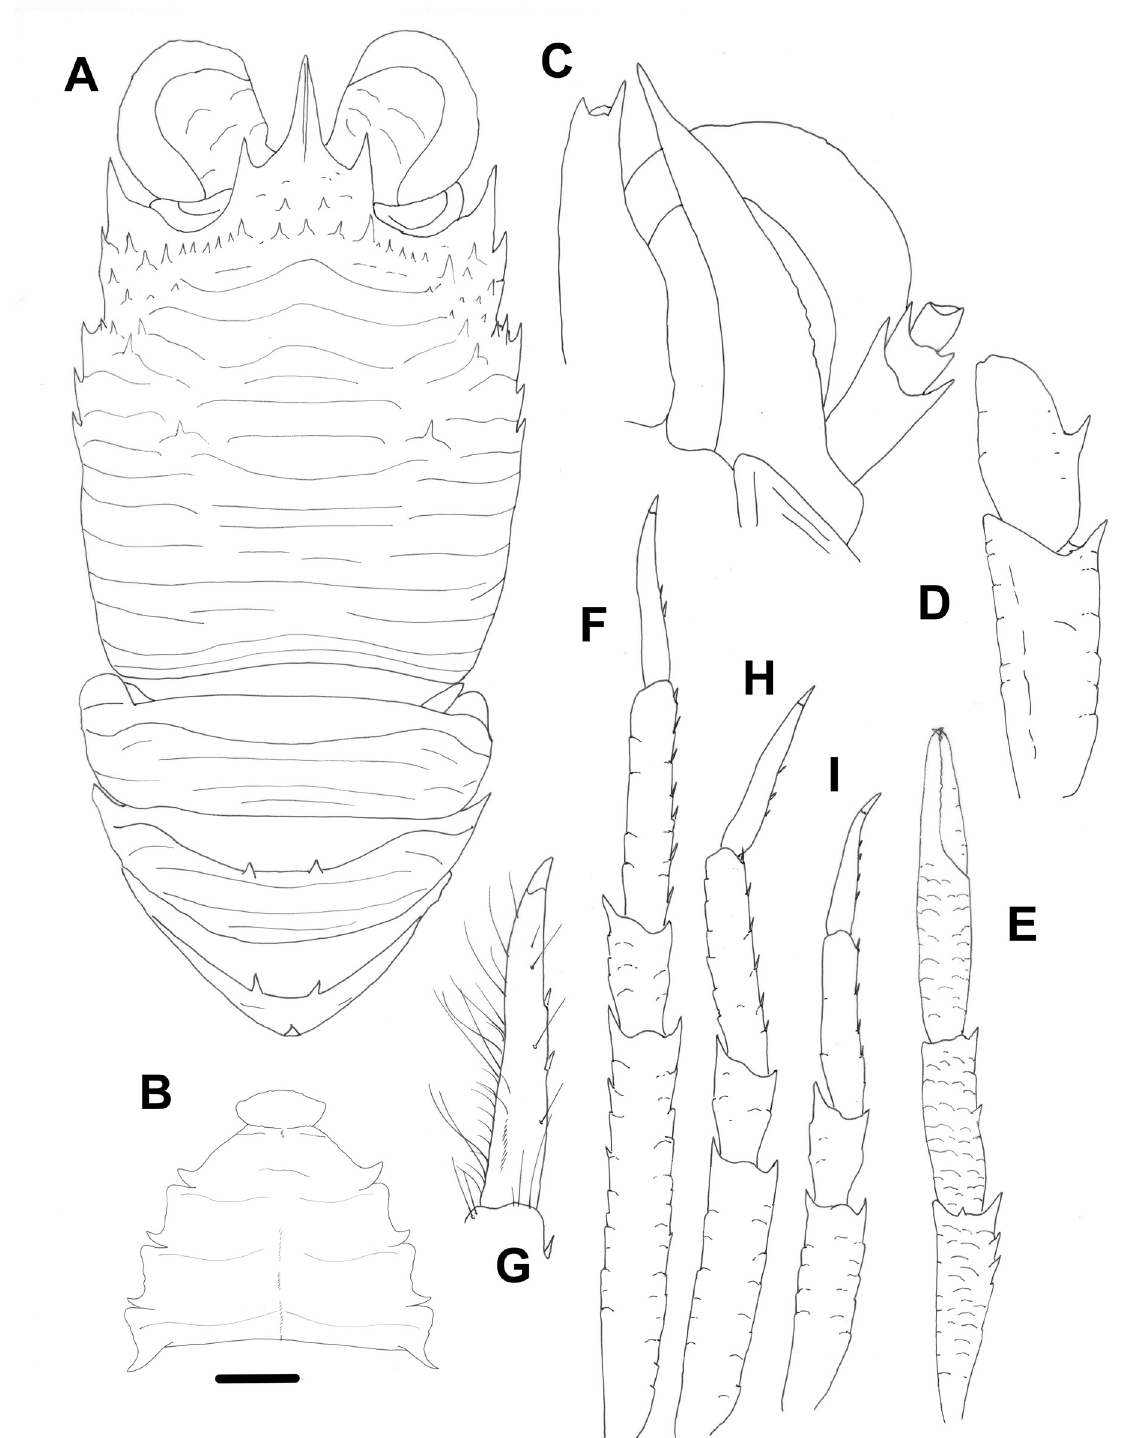
Fig. 2. Torbenella aequabilis sp. nov., holotype, ♀, CL = 6.6 mm (MNHN-IU-2017-8750), New Caledonia. A . Carapace and abdomen, dorsal view. B . Sternal plastron. C . Cephalic region, showing antennular and antennal peduncles, ventral view. D . Right Mxp3, lateral view. E . Left P1, dorsal view. F . Right P2, lateral view. G . Dactylus of right P2, lateral view. H . Right P3, lateral view. I . Right P4, lateral view. Scale bar: A–B, F, H–I = 1.0 mm; C–D, G = 0.5 mm; E = 2